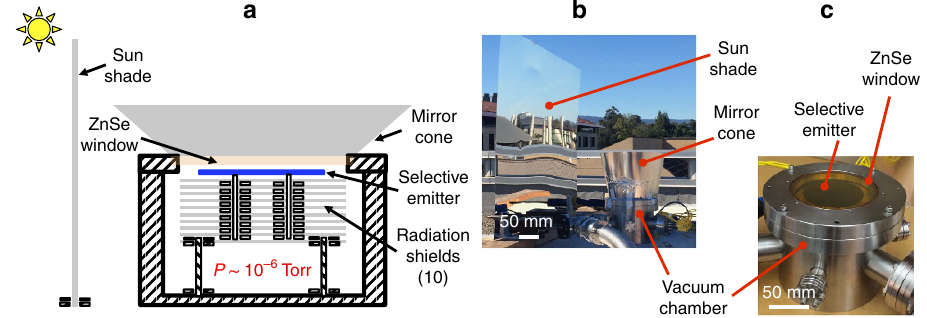
Figure 2 | Experimental concept. ( a ) Schematic of the experimental set-up. The key feature is to minimize parasitic heat losses of convection and air conduction using a vacuum system. Radiation shields and long-hollow ceramic pegs are exploited to further reduce the radiation and conduction losses through the backside of the selective emitter. The shinny sun-shade and mirror-cone are used to minimize solar irradiance. ZnSe is selected for its transparency in the mid-infrared wavelength range (red line in Fig. 3b). ( b ) In situ experimental set-up. ( c ) Details of the vacuum chamber, including the selective emitter and the ZnSe window.